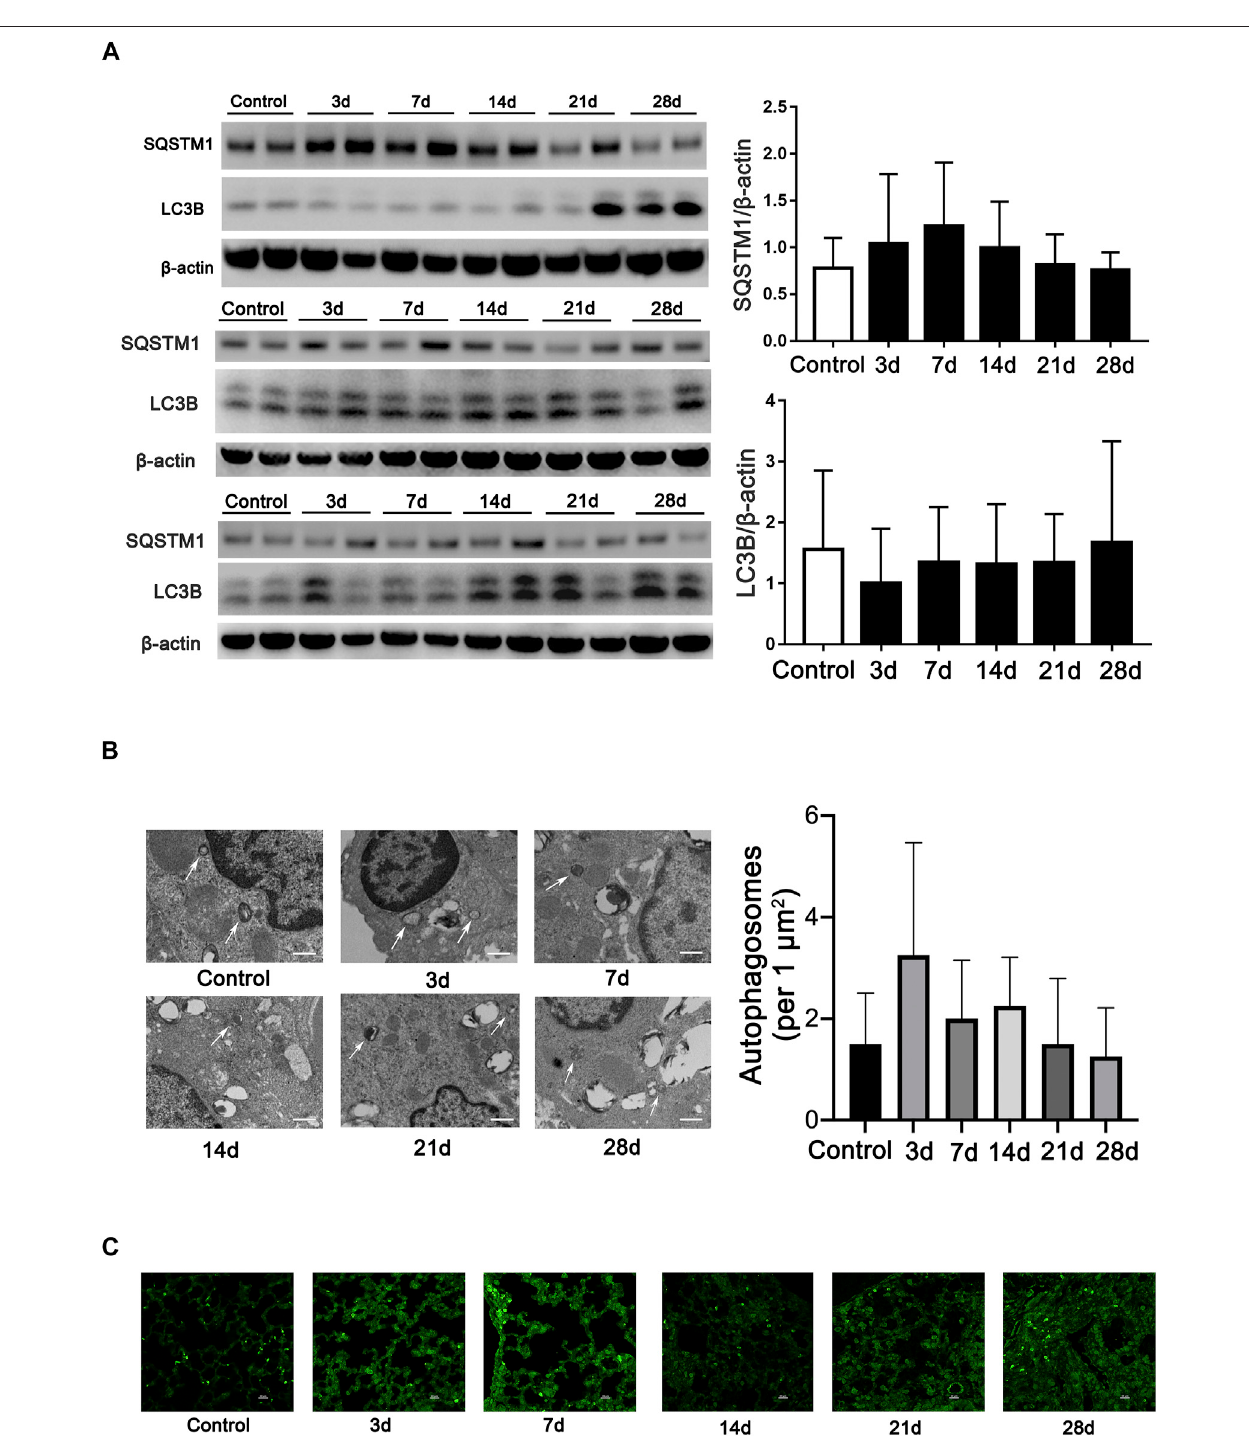
FIGURE1| Autophagyisnotcontinuallyinducedinpulmonary fi brosismousemodels. (A) Immunoblotsandsemiquanti fi cation( n (cid:2) 6)forSQSTM1(P62)andLC3B in mouse lung tissue on the indicated days post-bleomycin. Mouse lung tissue was collected and subjected to Western blotting using the indicated antibodies. (B) Representative transmission electron microscopyimages ofautophagosomes and semiquanti fi cation ofautophagosomes ( n (cid:2) 6) inpulmonaryalveolar epithelial cellsof post-bleomycin mice on the indicated days. White arrows represent autophagosomes. Scale bar: 1 μ m. (C) Representative fl uorescence microphotographs of LC3B dots in mouse lung tissue. Scale bar: 20 μ